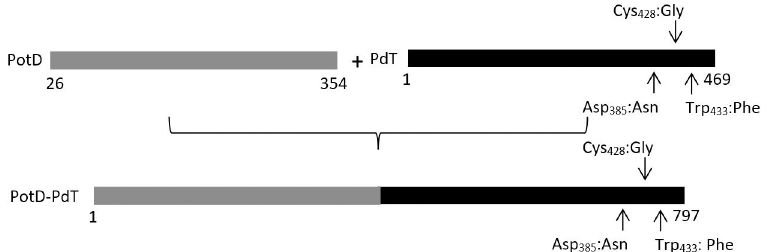
Fig 1. Scheme of recombinant proteins PotD and PdT and assembly of the hybrid. The amino acid substitutions are included for